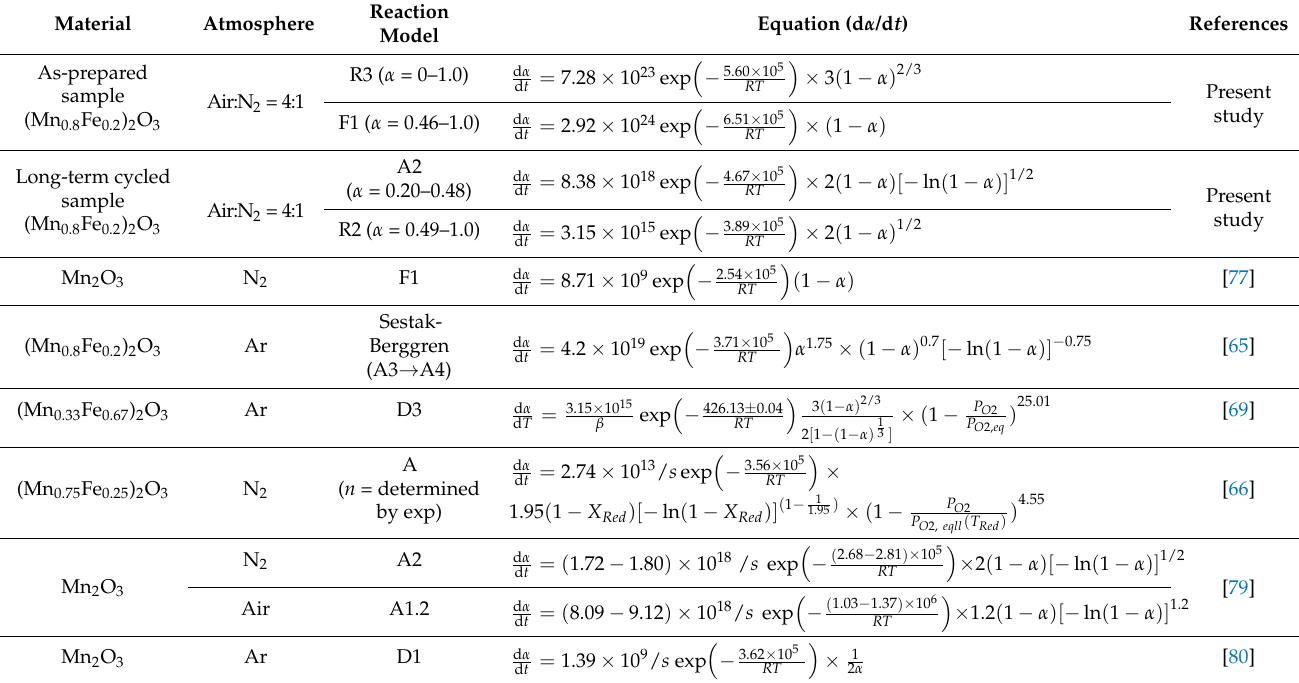
Table 1. Kinetic equations of the HC mode for the present and previous studies using Fe-substituted Mn 2 O 3 . The kinetic data for non-substituted Mn 2 O 3 samples are listed as a